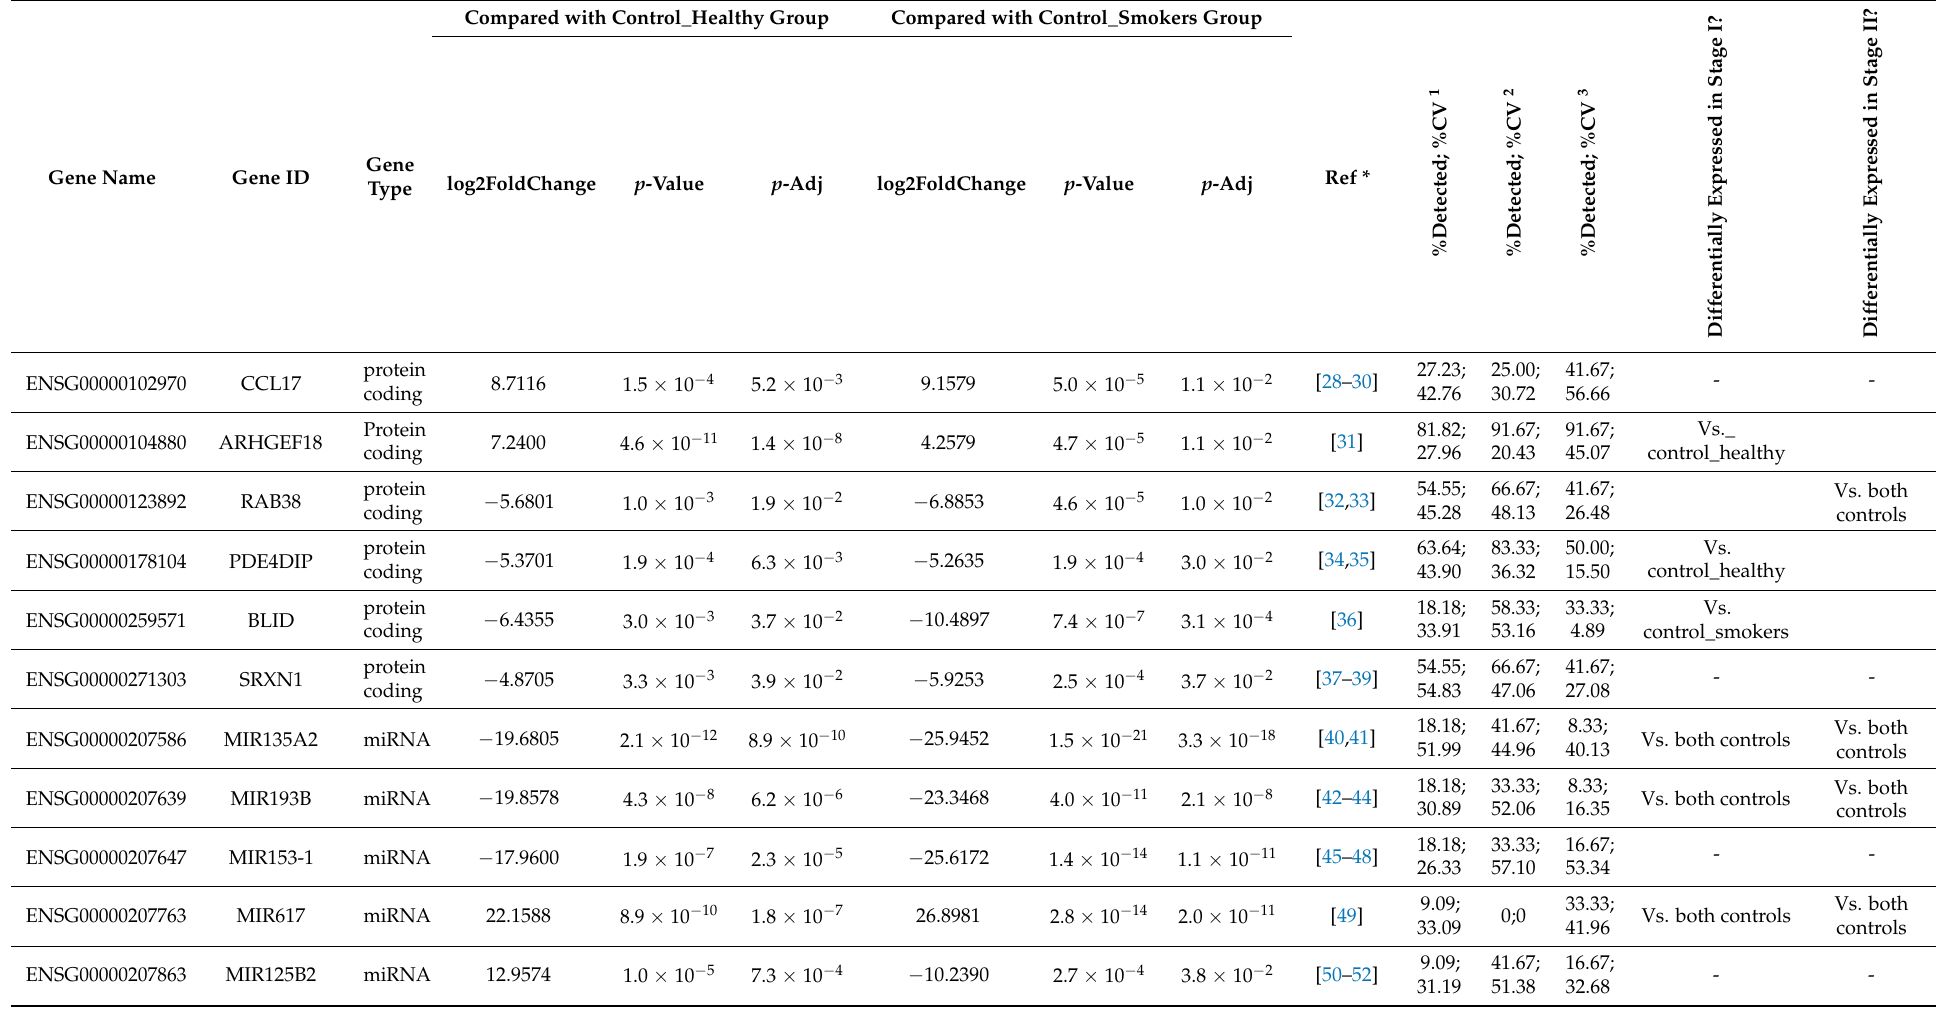
Table 2. cfRNA differentially expressed in cases compared with both control groups and confirmed by published